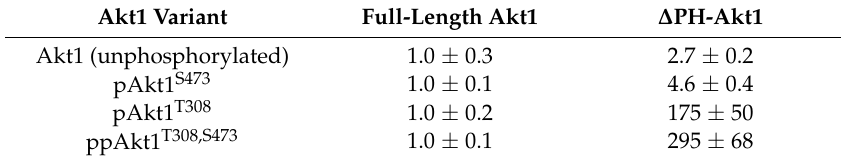
Table 3. Relative activity of full-length Akt1 versus variants lacking the PH domain ( ∆ PH Akt1)